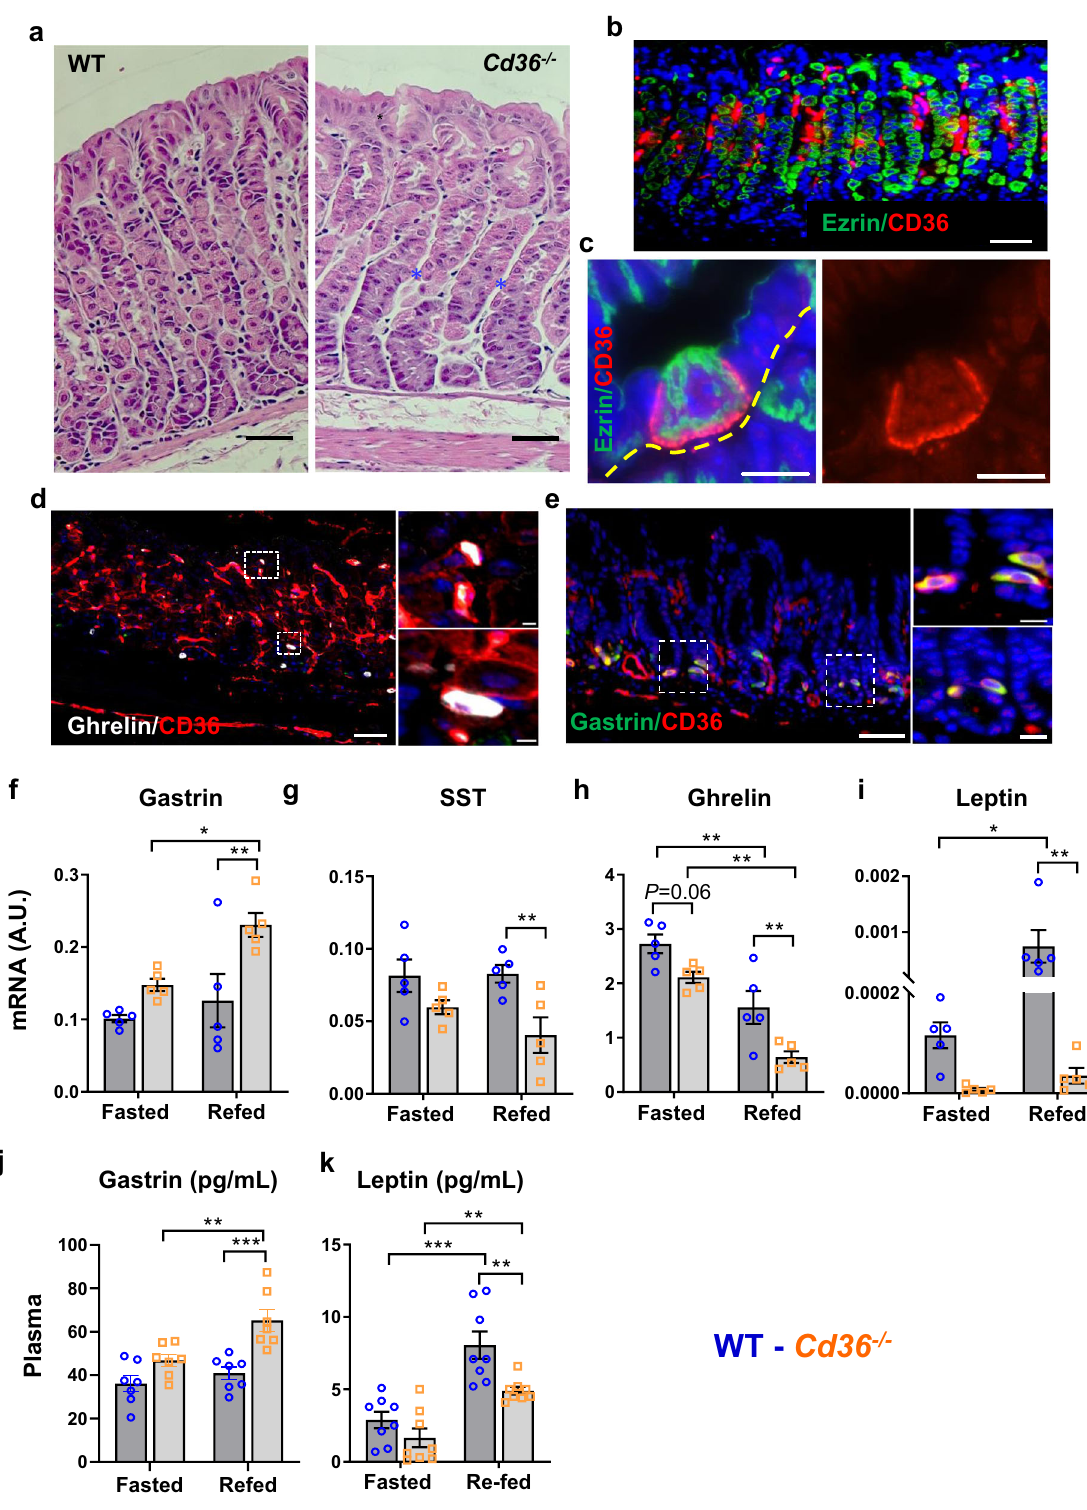
exchange of metabolites with the blood 29 . Extracellular matrix (ECM) remodeling was evident under steady state conditions in stomachs from nonfasted Cd36 − / − mice; speci fi cally higher mRNA for fi bronectin (Fig. 3b) and fi bronectin deposition around vessels and in submucosa (Fig. 3c). Other ECM markers, including laminin and collagen 1 α did not change (Fig. 3b). In fl ammation markers assessed during fasting and